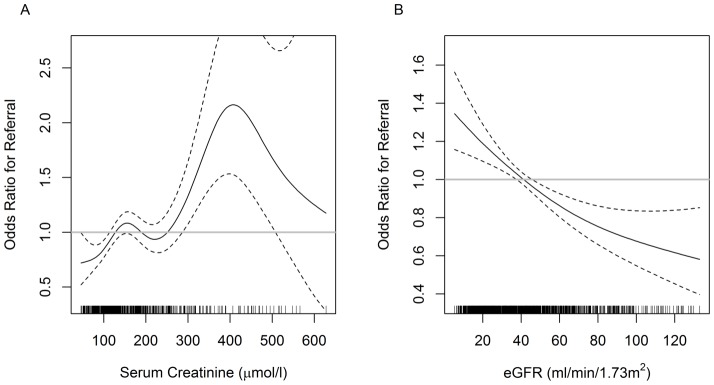
Adjusted odds of a patient having been referred to a nephrologist by a specialist in relation to serum creatinine (A) and eGFR (CKD-Epi), (B) during the study visit.Models were adjusted for age, gender, race, presence of diabetic renal disease, center, systolic and diastolic blood pressure and time the patient had been under nephrology care. Solid black line: estimated adjusted odds ratio, dashed black lines: associated pointwise 95% confidence internal, gray horizontal line: corresponds to an odds ratio of one.